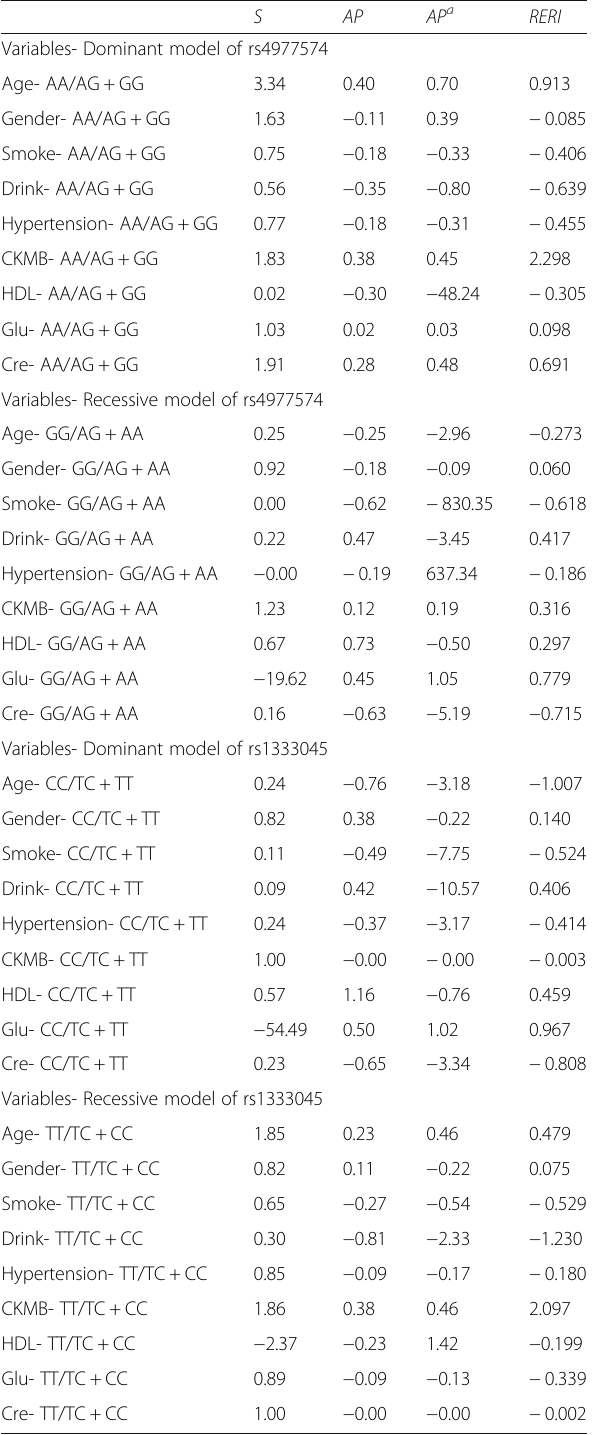
Table 8 The indexes of the synergistic effect between the dominant model, recessive model and risk factors